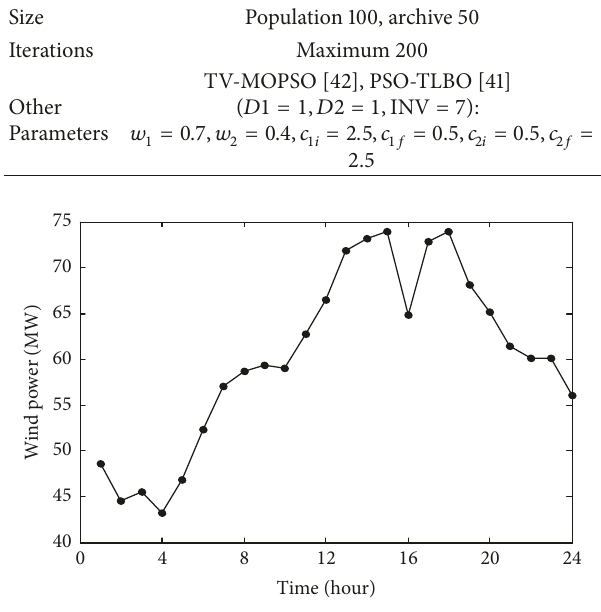
Figure 2: Predicted wind power for the 24 hours, next